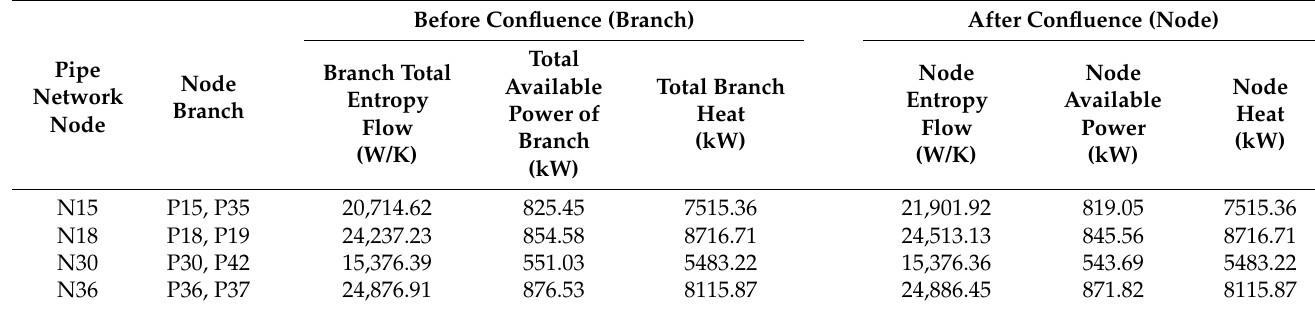
Table 4. Related thermodynamic parameters of typical heating network nodes Case